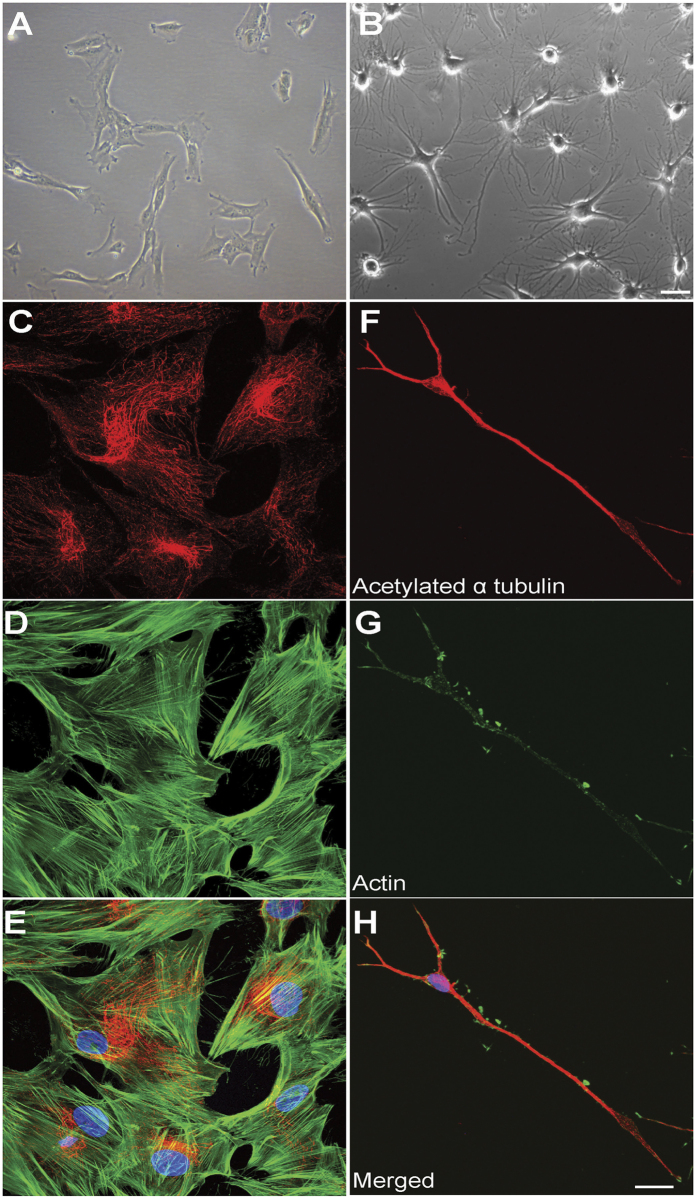
Axon-like processes induced by neuronal differentiation of ONS cells.(A) Phase-contrast image of control ONS cells in normal growth medium. (B) Phase contrast image of control ONS cells grown in cytochalasin (D) neuron-induction medium to generate immature neurons with axon-like processes. (C–E) The same field of undifferentiated ONS cells labelled with an antibody to acetylated α-tubulin (red, C) and phalloidin labelling of actin (green, D), and merged with nuclei labelled with DAPI (blue, E). (F–H) The same field showing a differentiated cell labelled with an antibody to acetylated α-tubulin (red, F) and phalloidin labelling of actin (green, G), and merged with nuclei labelled with DAPI (blue, H). In ONS cells microtubules and actin filaments overlap. Differentiated cells have microtubules but the actin filaments are depleted. Scale bar in (B) applies to (A,B) 100 μm. Scale bar in (H) applies to (C–H) 20 μm.